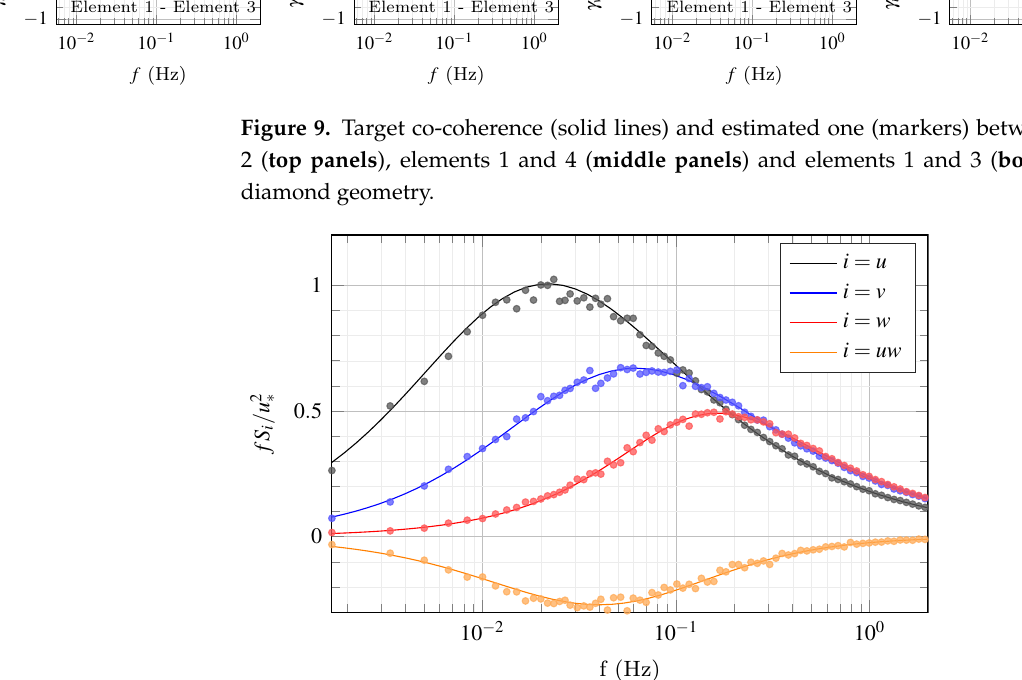
Figure 10. Target and computed power spectral densities estimates on e 1 .